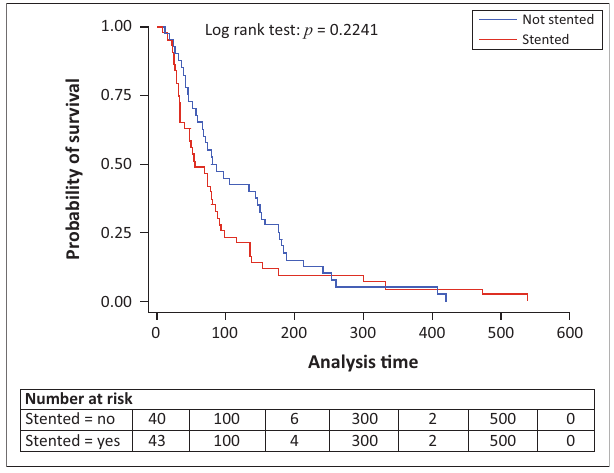
FIGURE 5: Kaplan-Meier survival estimates for DPFS in patients with or without stent insertion who received palliative RT.